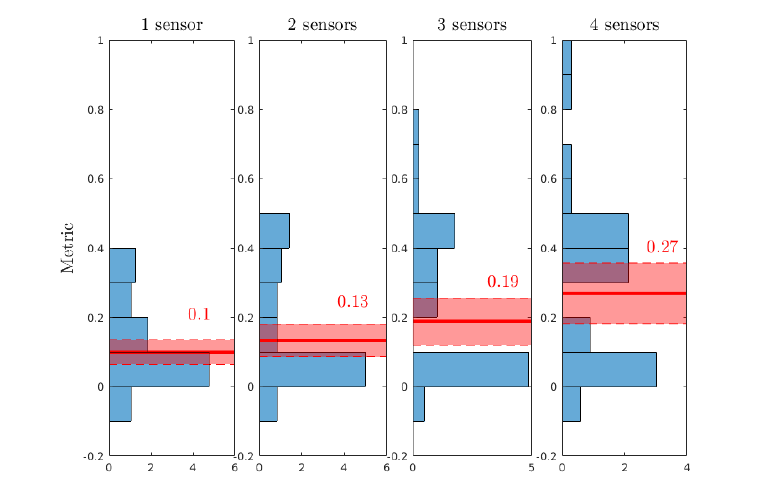
Figure 19. Histograms of the conditional entropy metric considering ( a , b and ρ ) parameters depending on the number of